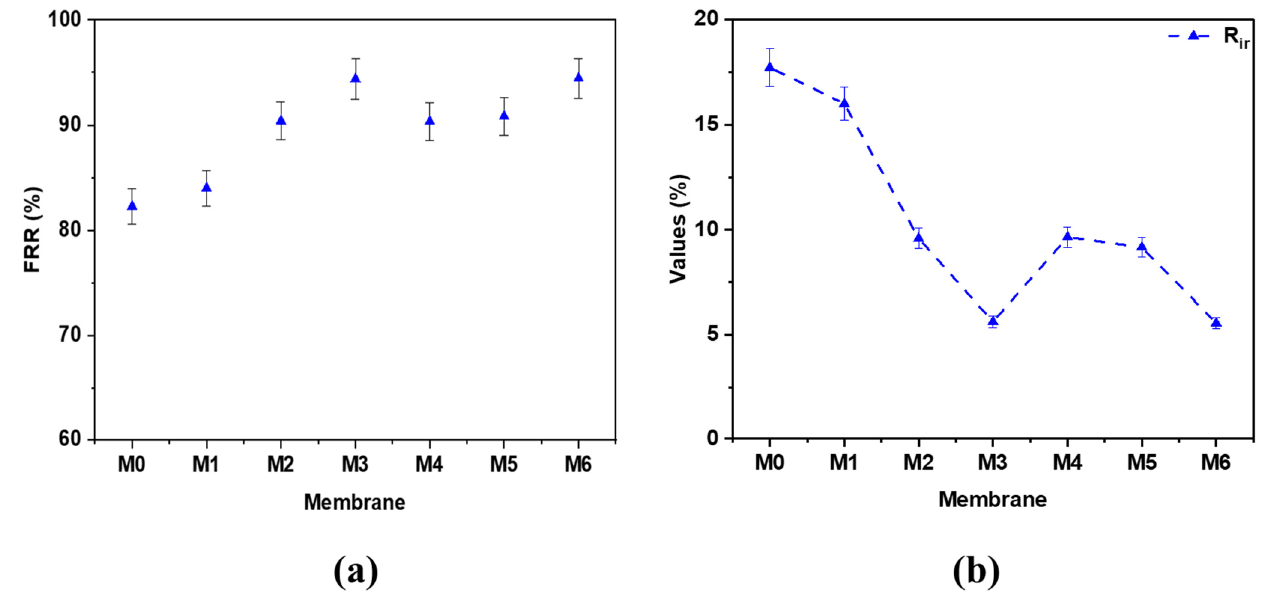
Figure 11. ( a ) Flux recovery ratios (FRR), and ( b ) irreversible resistance (R ir ) for bare PES, PES/MWCNTs, and PES/GO hybrid membranes after ultrafiltration of HA solution (50 mg L − 1 , pH = 7) and subsequent washing with DW.